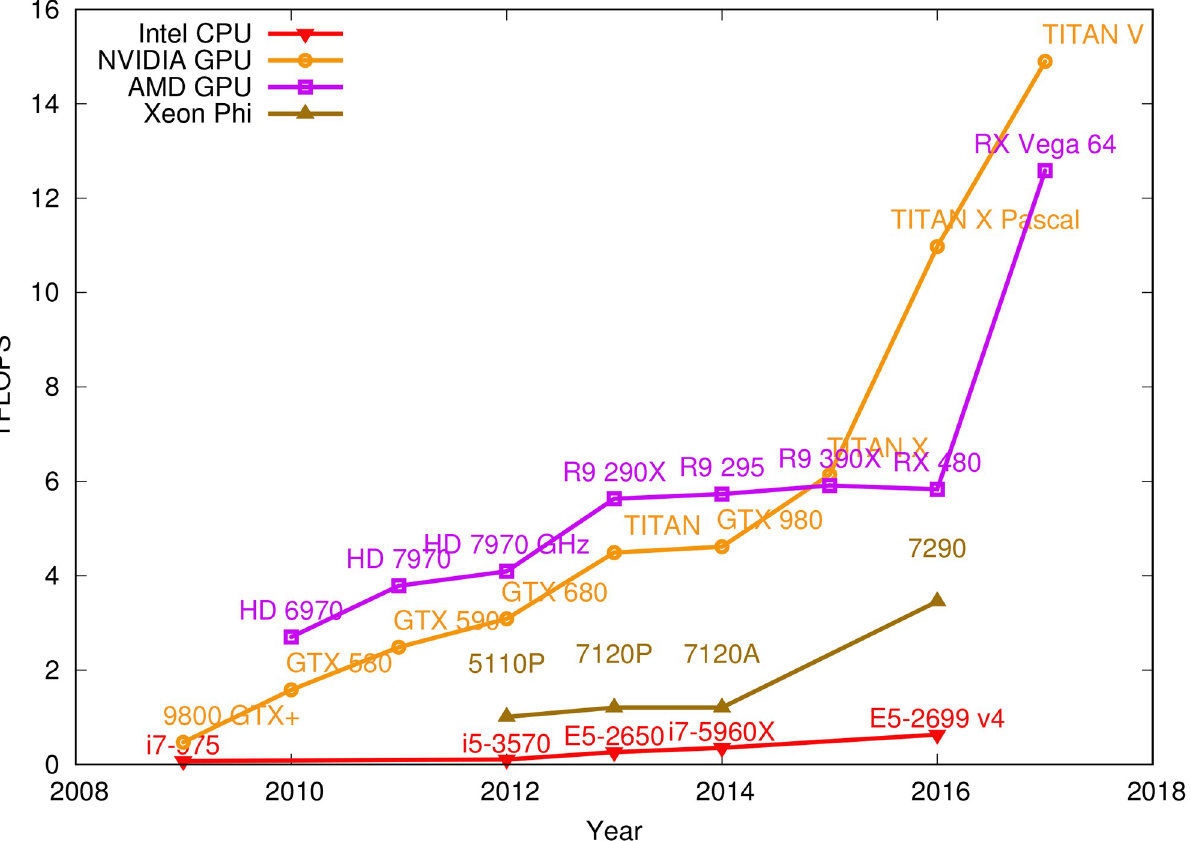
Fig 1. Growth of computing capacity on Intel CPU, Intel Phi co-processor, and NVidia/AMD GPUs. Data extracted from [1, 2].